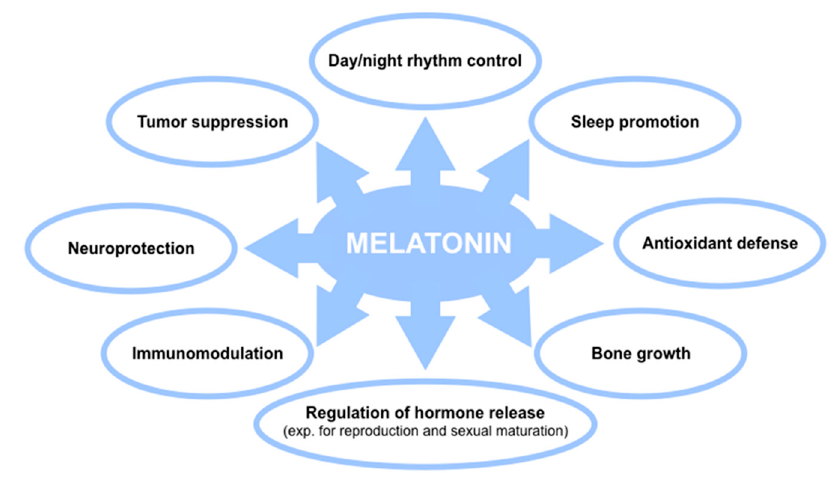
Figure 4. The main roles and functions of melatonin in humans.